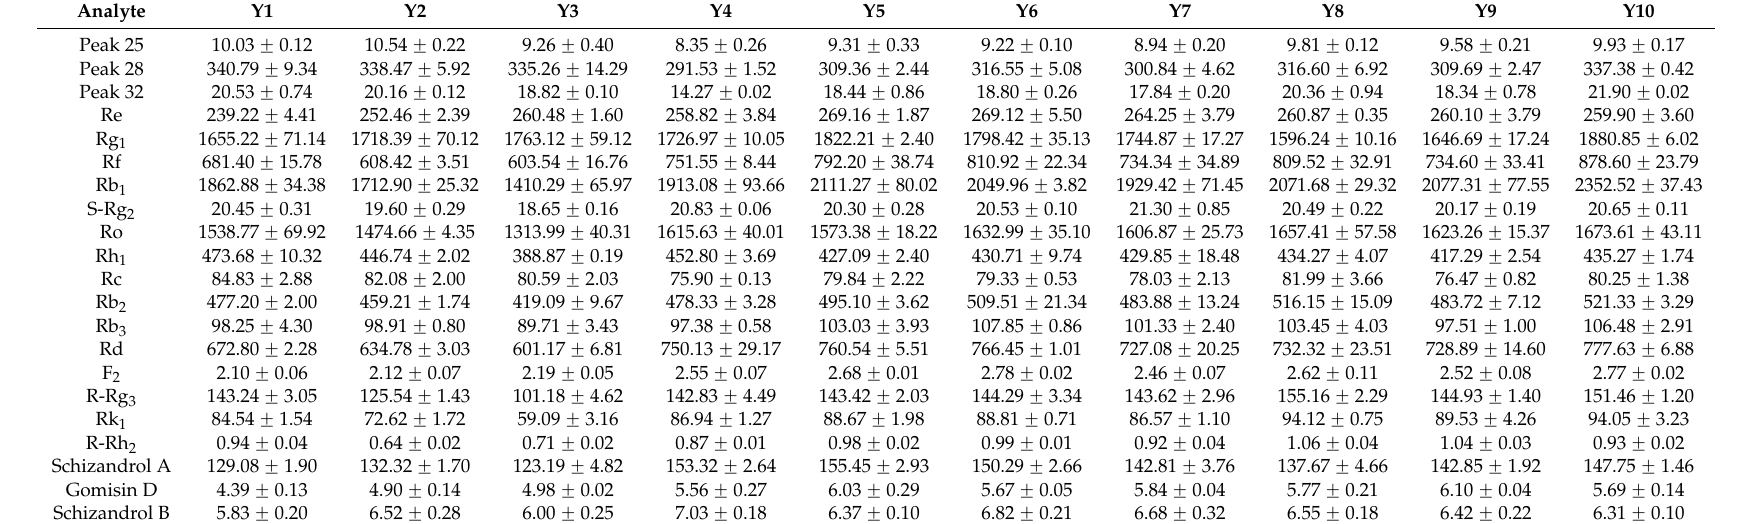
Table 1. The contents of 21 compounds in 10 batches of YQFM ( µ g/g, mean ˘ SD, n =